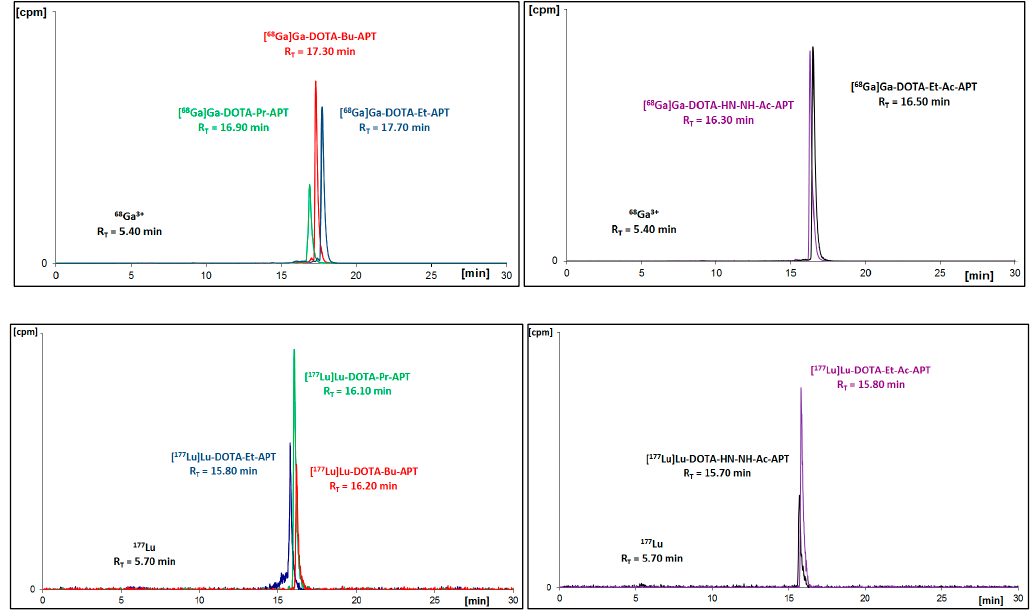
Figure 3. Radio c hromatograms of DOTA conjugates with all APT derivatives radiolabeled with gallium ‐ 68 (upper two) or with lutetium ‐ 177 (bottom two).